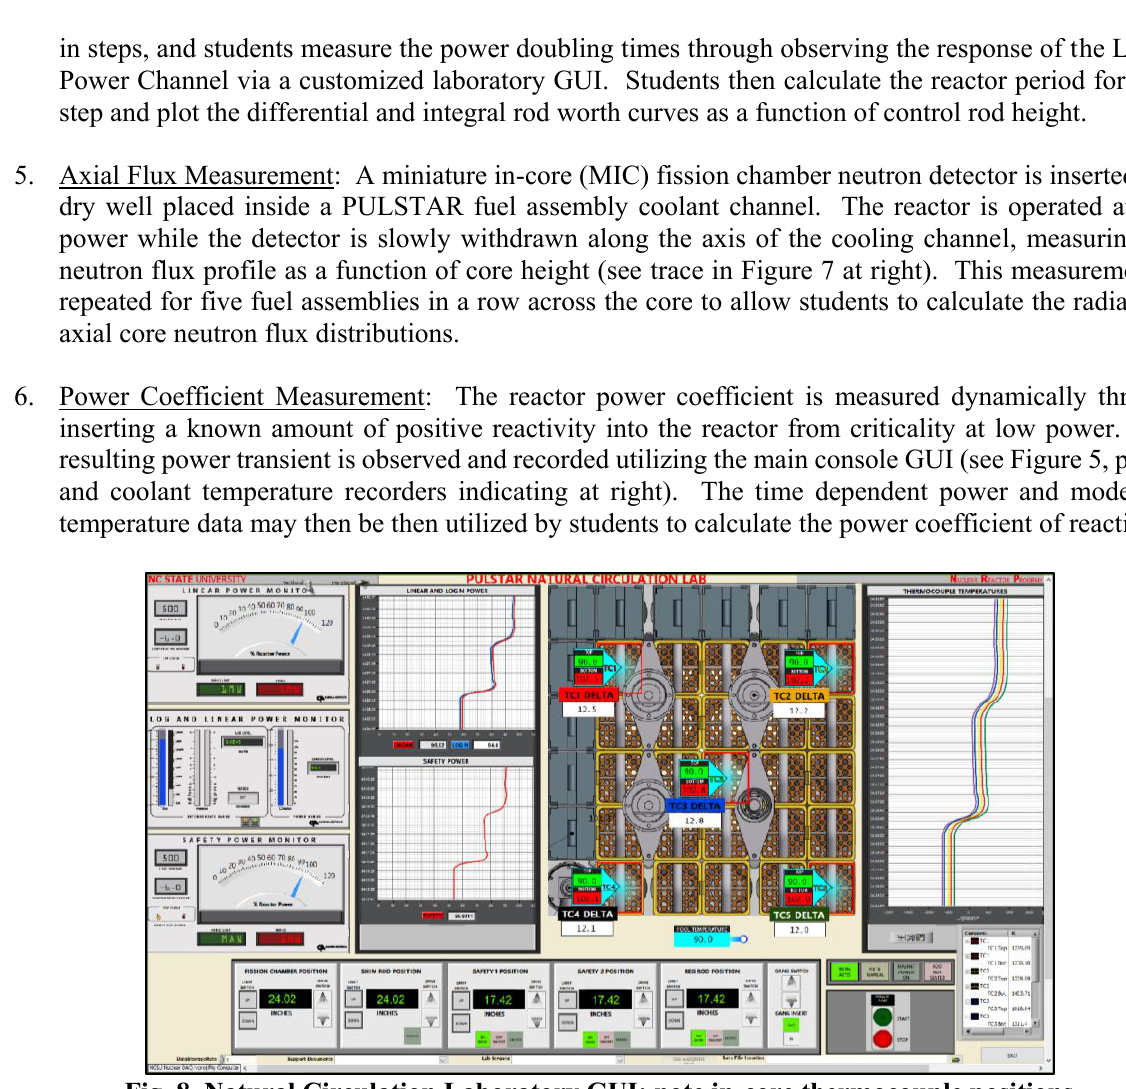
Fig. 8. Natural Circulation Laboratory GUI; note in-core thermocouple positions with instantaneous temperature readouts, power level traces at center left, and transient coolant channel temperature traces at